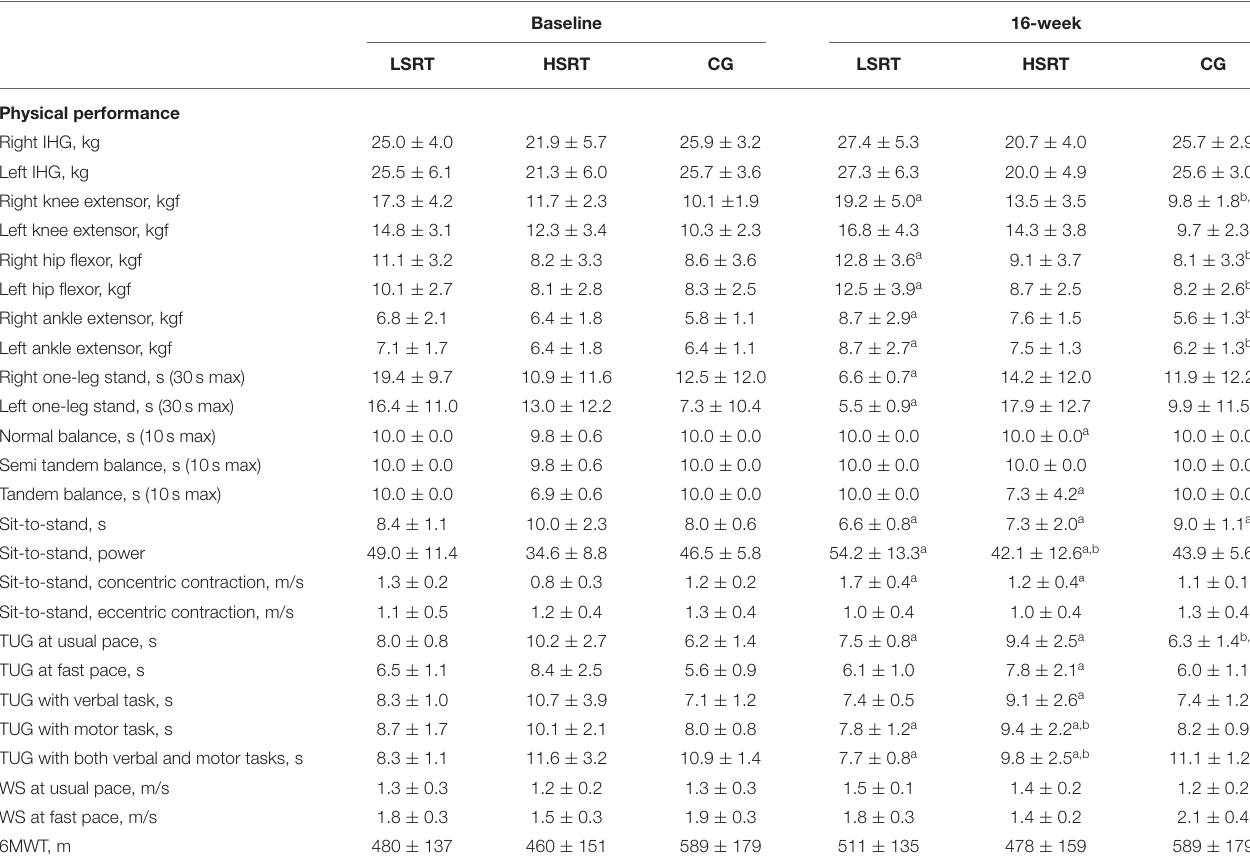
TABLE 2 | Effects of resistance training on physical performance of pre-frail older